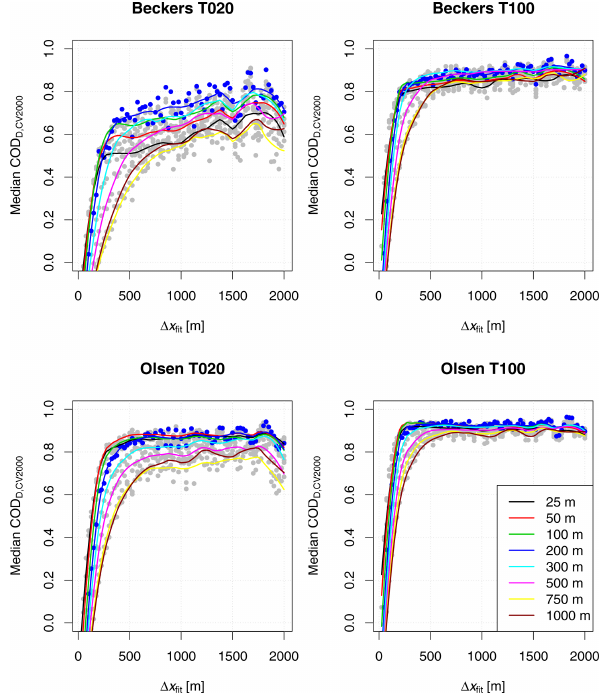
Figure 7. COD D , CV2000 considering flood damage regression mod- els (DMOD1) fitted at different data resolutions ( (cid:49)x fit ) and con- sidering building data aggregated to different resolutions in meters (lines with varying colors). Lines were smoothed, while dots indi- cate the true COD D , CV2000 values derived from each combination of fitting resolution and building input data resolution. Dots were colored blue for a building data resolution of 200m and grey other- wise.